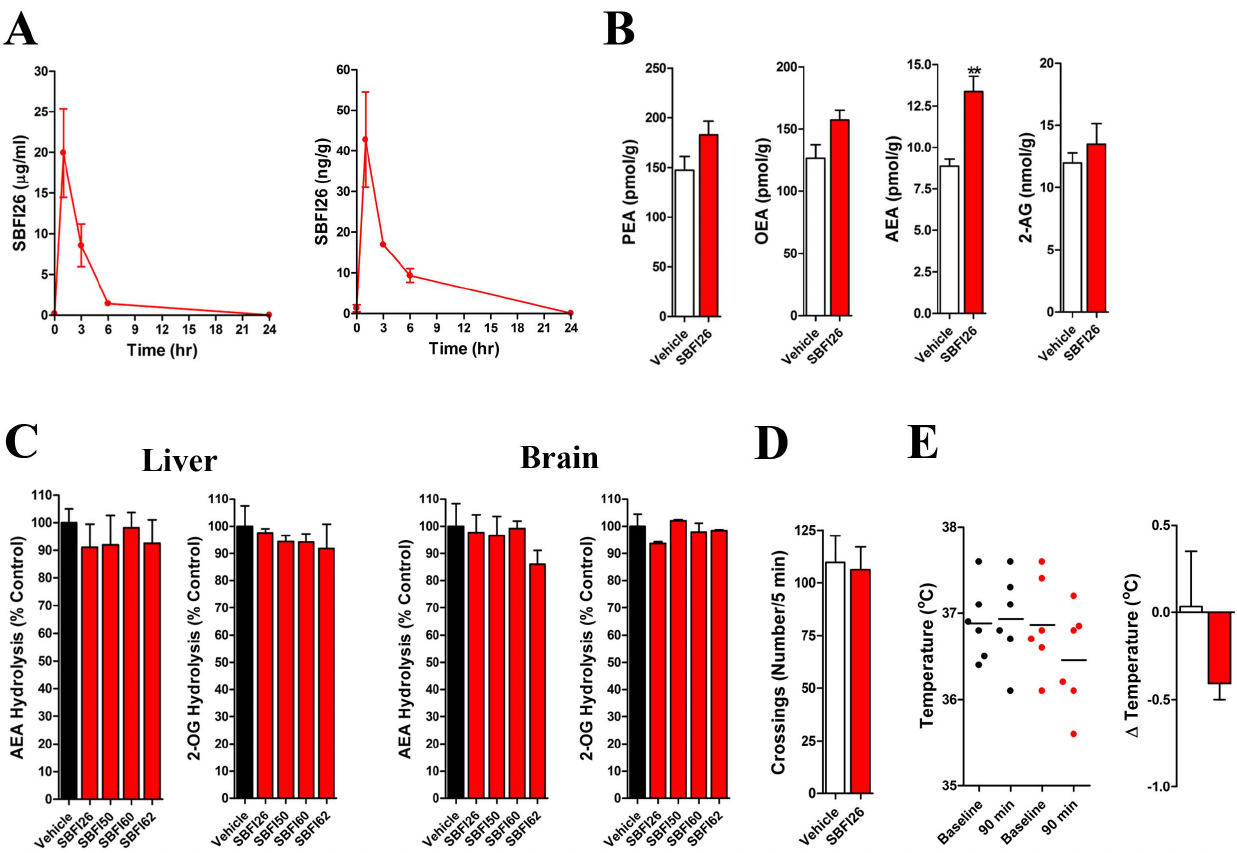
Figure 3. SBFI26 pharmacokinetics and its effect upon brain endocannabinoid levels. (A) Time course of SBFI26 levels in mouse plasma (left panel) and brain (right panel) following a single injection (20 mg/kg, i.p.) (n=5). (B) SBFI26 (20 mg/kg, i.p.) elevates brain levels of the AEA. Tissues were harvested 90 min after SBFI26 administration. **, p , 0.01 (n=6). (C) Effect of FABP inhibitors (20 mg/kg, i.p.) upon AEA and 2-OG hydrolysis by mouse brain and liver homogenates following a single injection (n=3). (D) SBFI26 (20 mg/kg, i.p.) does not alter locomotor activity in mice. Locomotor activity was measured 90 min after SBFI26 administration (n=6). (E) SBFI26 (20 mg/kg, i.p.) does not reduce rectal temperature in mice. Left graph: scatterplot of rectal temperatures at baseline and 90 min following injection of vehicle (black circles) or SBFI26 (red circles). Right graph: change in rectal temperature between baseline and 90 min following administration of vehicle (white bar) or SBFI26 (red bar). Statistical analysis was performed by paired t-test (p=0.205) (n=6). doi:10.1371/journal.pone.0094200.g003 PLOS ONE |